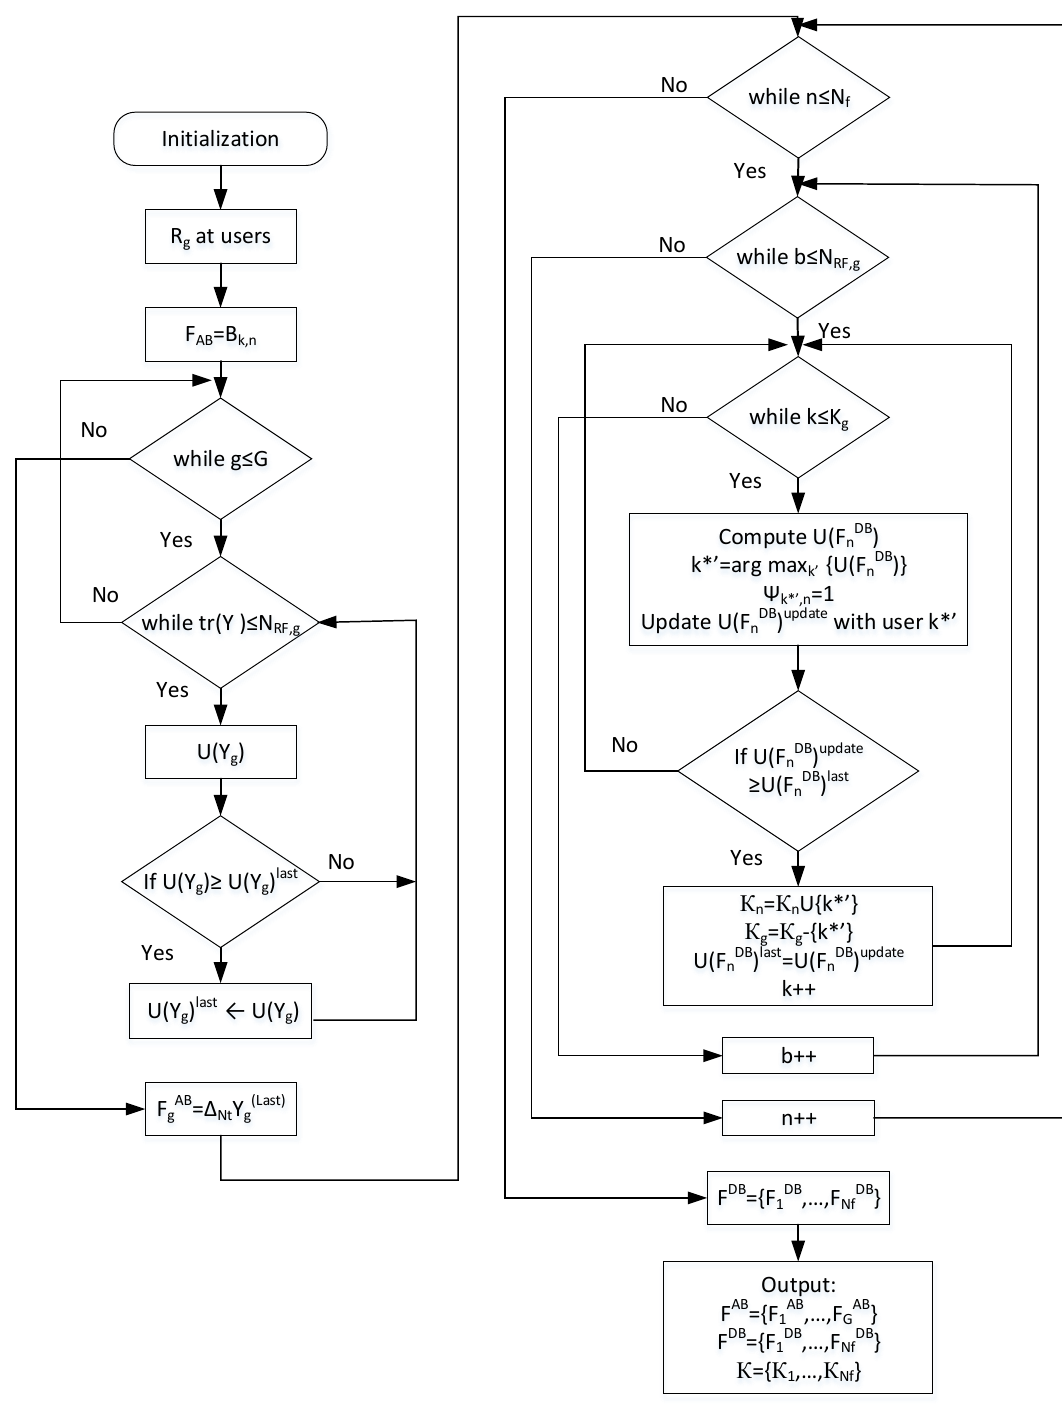
Figure 5. Flowchart illustration of Algorithm